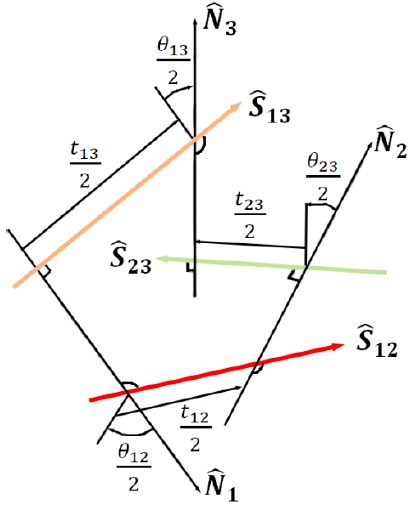
Figure 8. Screw triangle [25].